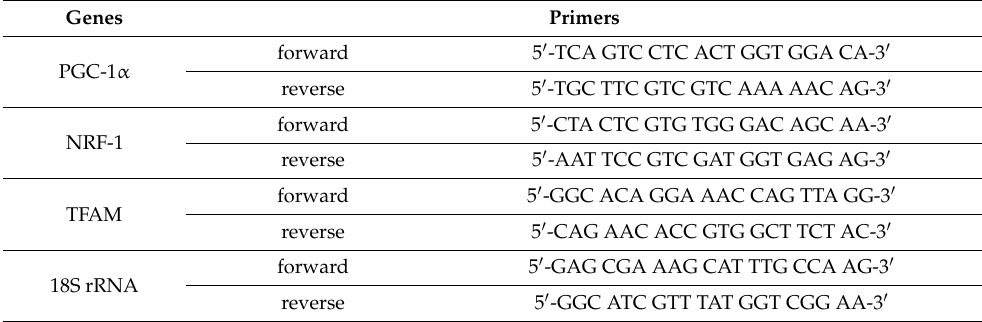
Table 1. Quantitative real-time polymerase chain reaction (qRT-PCR) primer sequences.